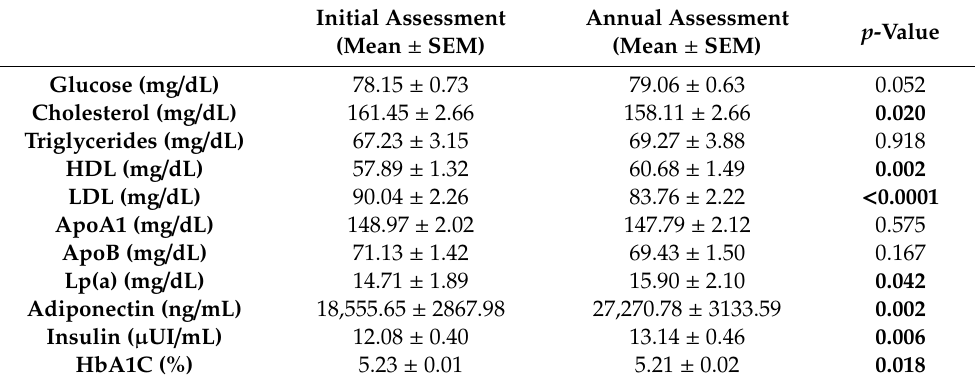
Table 7. Biochemical and endocrinologic parameters in subjects with